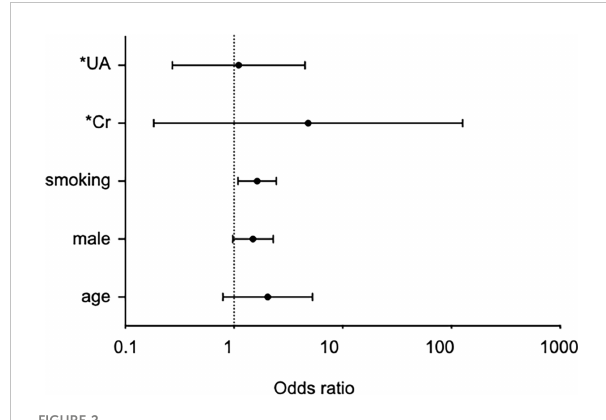
FIGURE 2 Forest plot summarizing multivariate logistic regression models for risk factor of elevated serum IgG4 levels. *Odds ratios for continuous variables are values that have changed over the entire range. UA, uric acid, Cr, creatinine. The x-axis shows odds ratios and the error bars show 95% con fi dence intervals.